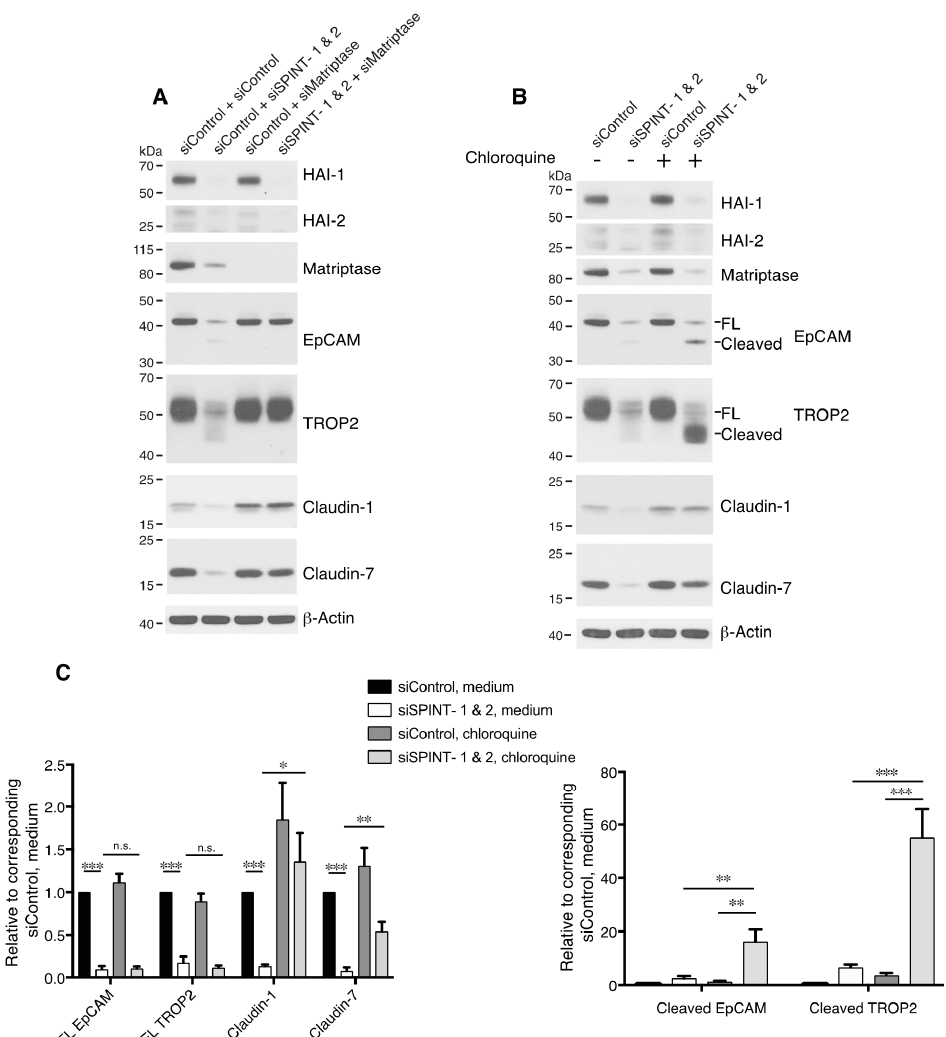
Figure 6. HAIs act via matriptase to regulate degradation of EpCAM, TROP2, and claudins in lysosomes. HaCaT cells were transfected using electroporation with control or SPINT1 plus SPINT2, matriptase, or SPINT1, SPINT2 plus matriptase siRNAs ( A ), or control or SPINT1 and SPINT2 siRNAs ( B ). Before being harvested at 72 h after transfection ( A , B ), cells were treated with or without 100 µ M chloroquine for 20 h ( B ). RIPA cell lysates were resolved using SDS-PAGE and immunoblotted with anti-HAI-1, anti-HAI-2, anti-matriptase, anti-EpCAM anti-TROP2, anti-claudin-1, or anti-claudin-7. β -actin was used as a loading control. Representative data from 1 of 5 experiments is shown. ( C ) Band intensities corresponding to full-length (FL) EpCAM, FL TROP2, claudin-1 and claudin-7 (left panel) and cleaved EpCAM and cleaved TROP2 (right panel) were quantified and normalized to β -actin. Data are plotted as ratios (means ± SEM) relative to corresponding untreated siControls ( n = 5). A two-way ANOVA was used to calculate p values for multiple group comparisons to assess mean di ff erences between groups (* p < 0.05, ** p < 0.01, *** p < 0.001 or 0.0001, n.s. p >